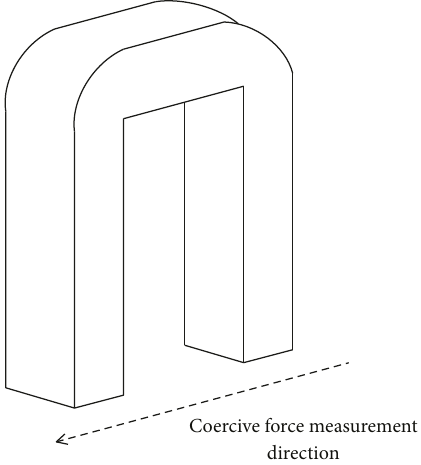
Figure 12: Schematic diagram of coercive force measurement direction.